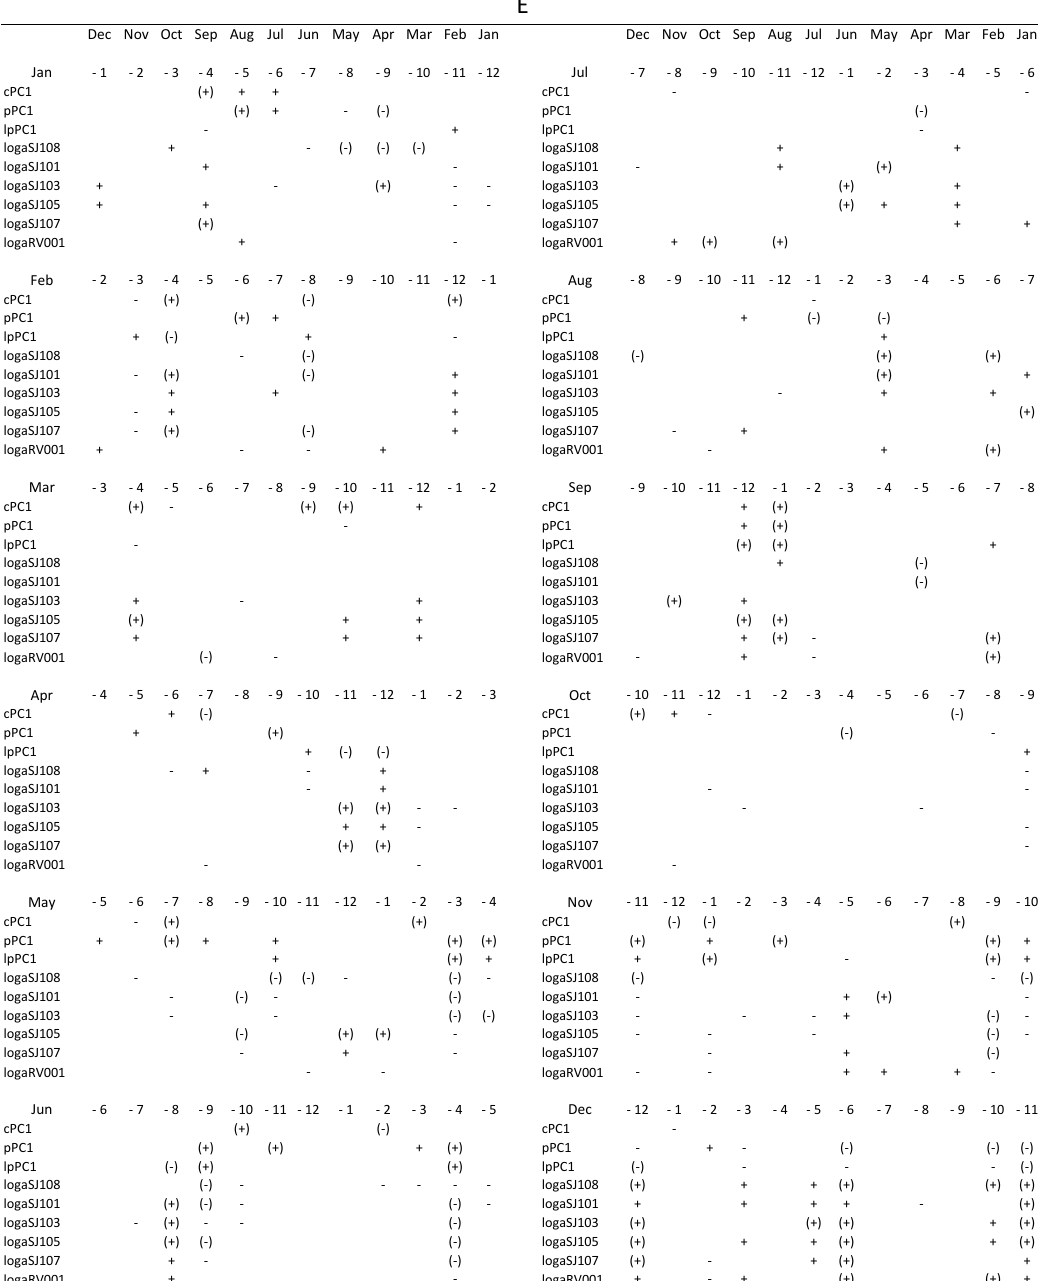
Table 2. Positive ( + ) or negative ( − ) correlation between changes in geostrophic currents (cPC1 scores)/phytoplankton original values (pPC1 scores)/transformed values (lpPC1 scores)/transformed average water column phytoplankton values at SJ108, SJ101, SJ103, SJ105, SJ107 and RV001 during 1990–2004 and changes in surface fluxes, evaporation (E) and precipitation (P) and Po River rates (Po) in preceding month. The time lags are between 1 and 12. The signs and signs in parentheses indicate significances of 80 and 95%,